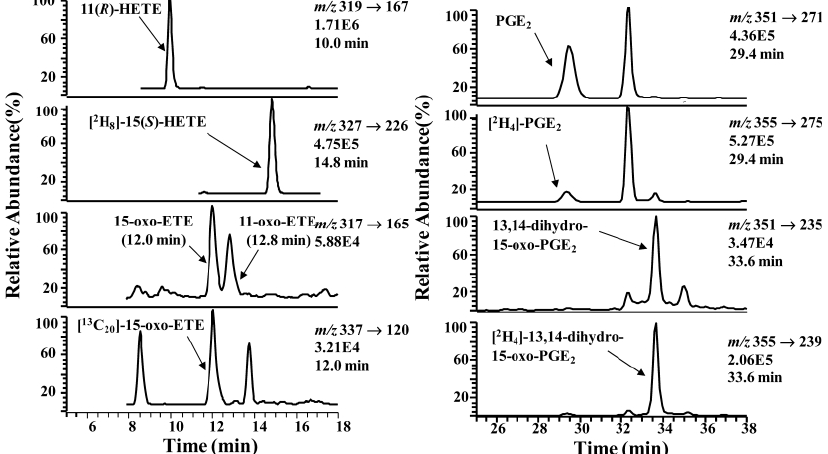
Figure 4. Targeted chiral lipidomics analysis of COX-2-derived eicosanoids from LoVo cells. LoVo cells were lysed; eicosanoids were extracted, derivatized with PFB bromide, and analyzed by LC-ECAPCI/SRM/MS. LoVo cell lysates were pretreated with 50 μ M CAY10397 to inhibit 15-PGDH to be able to detect the 11-, 15-HETEs and PGE . 2 Representative chromatograms are shown for (top to bottom) (a) 11( R )-HETE-PFB ( m / z 319 → 167), (b) [ 2 H ]-15( S )-HETE-PFB internal standard ( m / z 327 → 226), (c) 11-oxo- 8 ETE-PFB ( m / z 317 → 165) and 15-oxo-ETE-PFB ( m / z 317 → 165), (d) [ 13 C ]-15-oxo- 20 ETE-PFB internal standard ( m / z 337 → 120), (e) PGE -PFB ( m / z 351 → 271), (f) [ 2 H ]- 2 4 PGE -PFB ( m / z 355 → 275), (g) 13,14-dihydro-15-oxo-PGE -PFB ( m / z 351 → 235), (h) 2 2 [ 2 H ]-13,14-dihydro-15-oxo-PGE -PFB ( m / z 355 → 239). Reprinted with permission from 4 2 Ref.